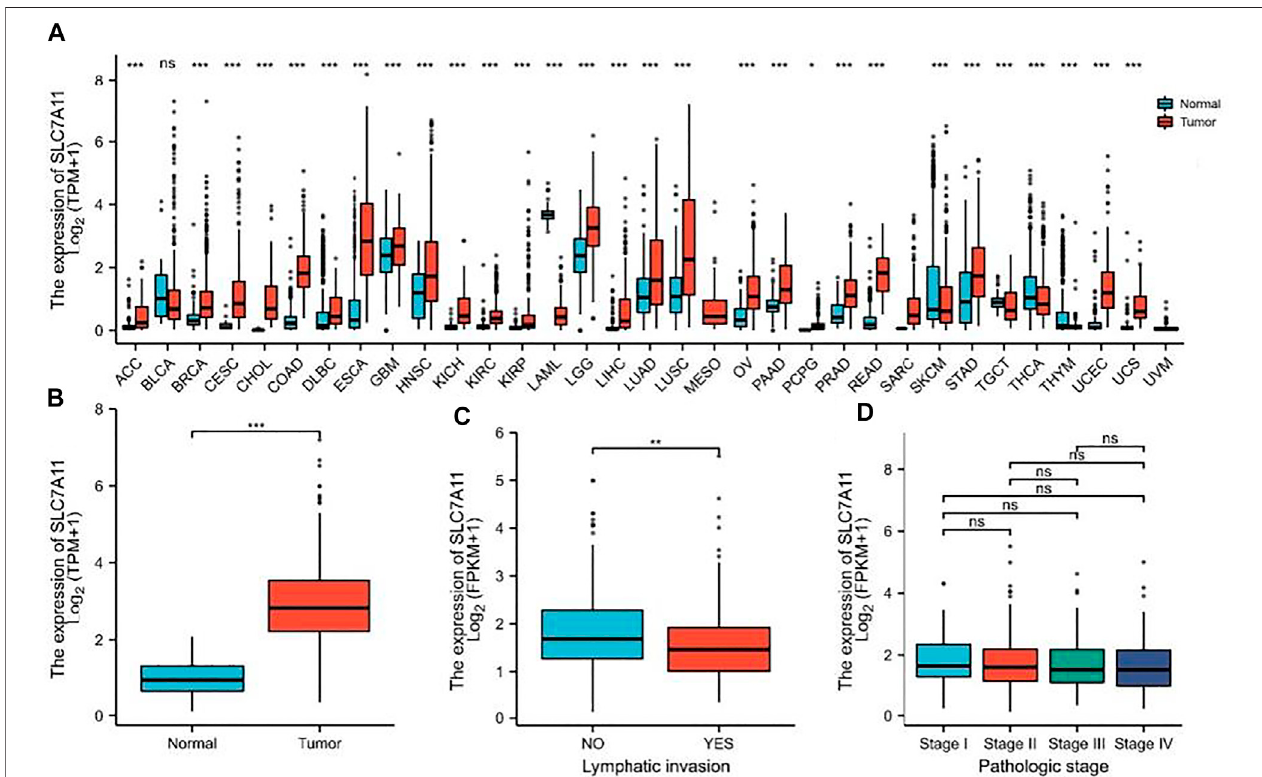
FIGURE 1 | SLC7A11 expression status in pan-cancer. (A) Expression of human SLC7A11 in distinct cancers compared with normal tissues. (B) Expression of SLC7A11 in COAD compared with normal tissues, n (normal) = 41 and n (tumor) = 480. (C) Comparison of SLC7A11 expression levels in lymphatic invasion, n (NO) = 266 and n (YES) = 168. (D) There was no signi fi cant difference in the SLC7A11 mRNA level among different pathological stages, n (Stage I, II, III, IV) = 81, 187, 133, 66, respectively. * p < 0.05. ** p < 0.01. *** p < 0.001. ns p >